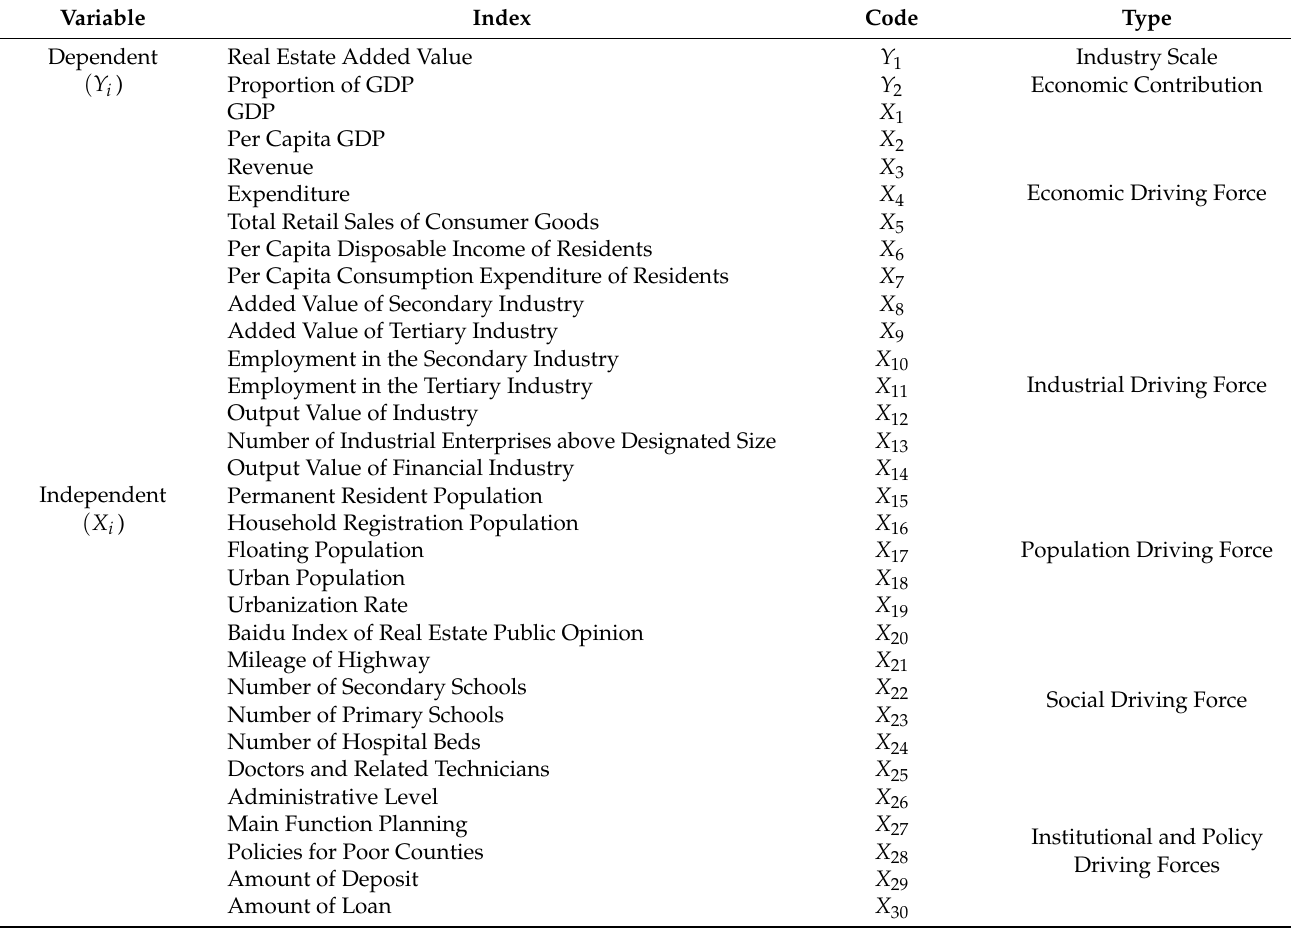
Table 1. Variable selection and its implication